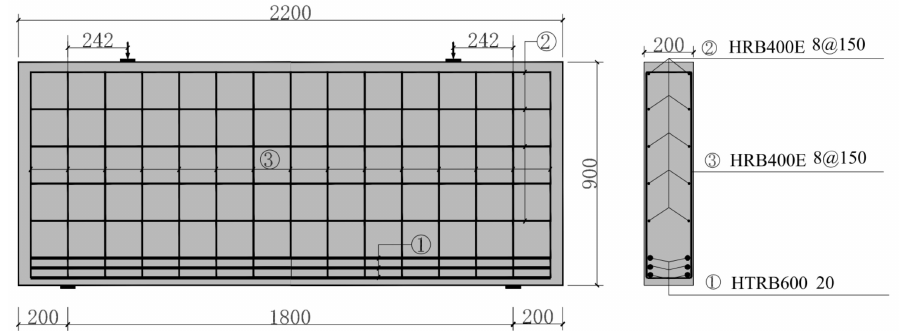
Figure 4. Specimen and reinforcement details (LDB1).